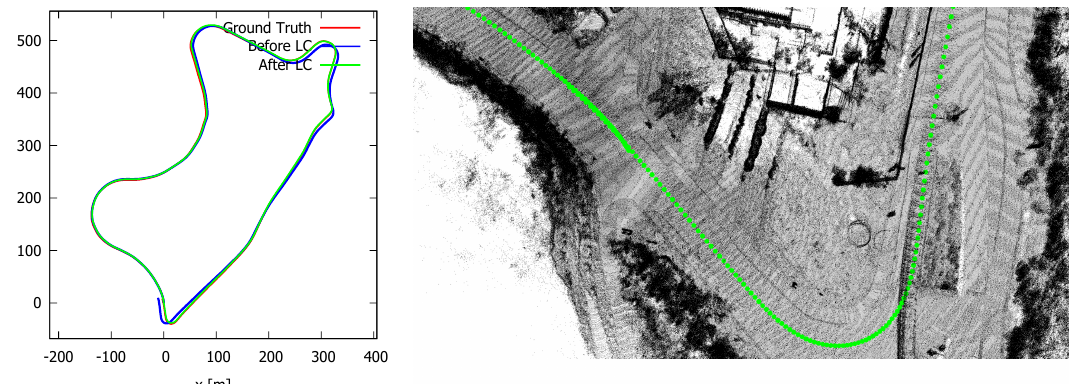
Figure 10. The resulting trajectory ( left ) of sequence “09” of the Kitti benchmark, before loop closure (blue) and after loop closure (green). The estimated and the ground truth trajectory are almost entirely overlapping after loop correction. ( right ) the corresponding reconstruction at the start- and end-point of the loop after correction. Little to no artefacts can be seen in the reconstruction. The pose error before and after loop correction is, respectively, 9.89 and 4.80 m, hence proving its effectiveness.